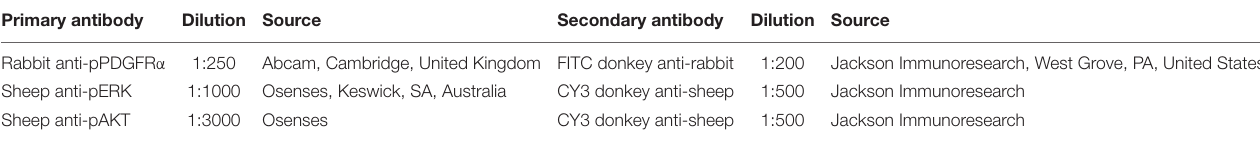
TABLE 1 | Antibodies used for immunohistochemistry. Primary antibody Dilution Source Secondary antibody